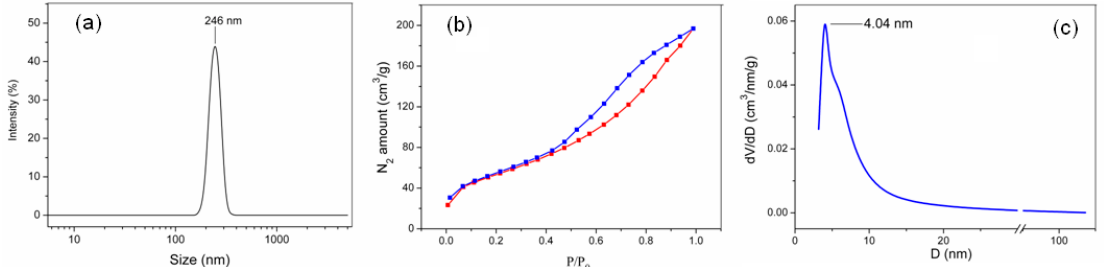
Figure 2. Characterization of montmorillonite (MMT) K10 powder: ( a ) Size distribution by intensity (dynamic light scattering (DLS)) particles; ( b ) isotherms of low-temperature nitrogen adsorption-desorption on particles; ( c ) Barrett-Joyner-Halenda (BJH) pore size distribution for MMT K10.